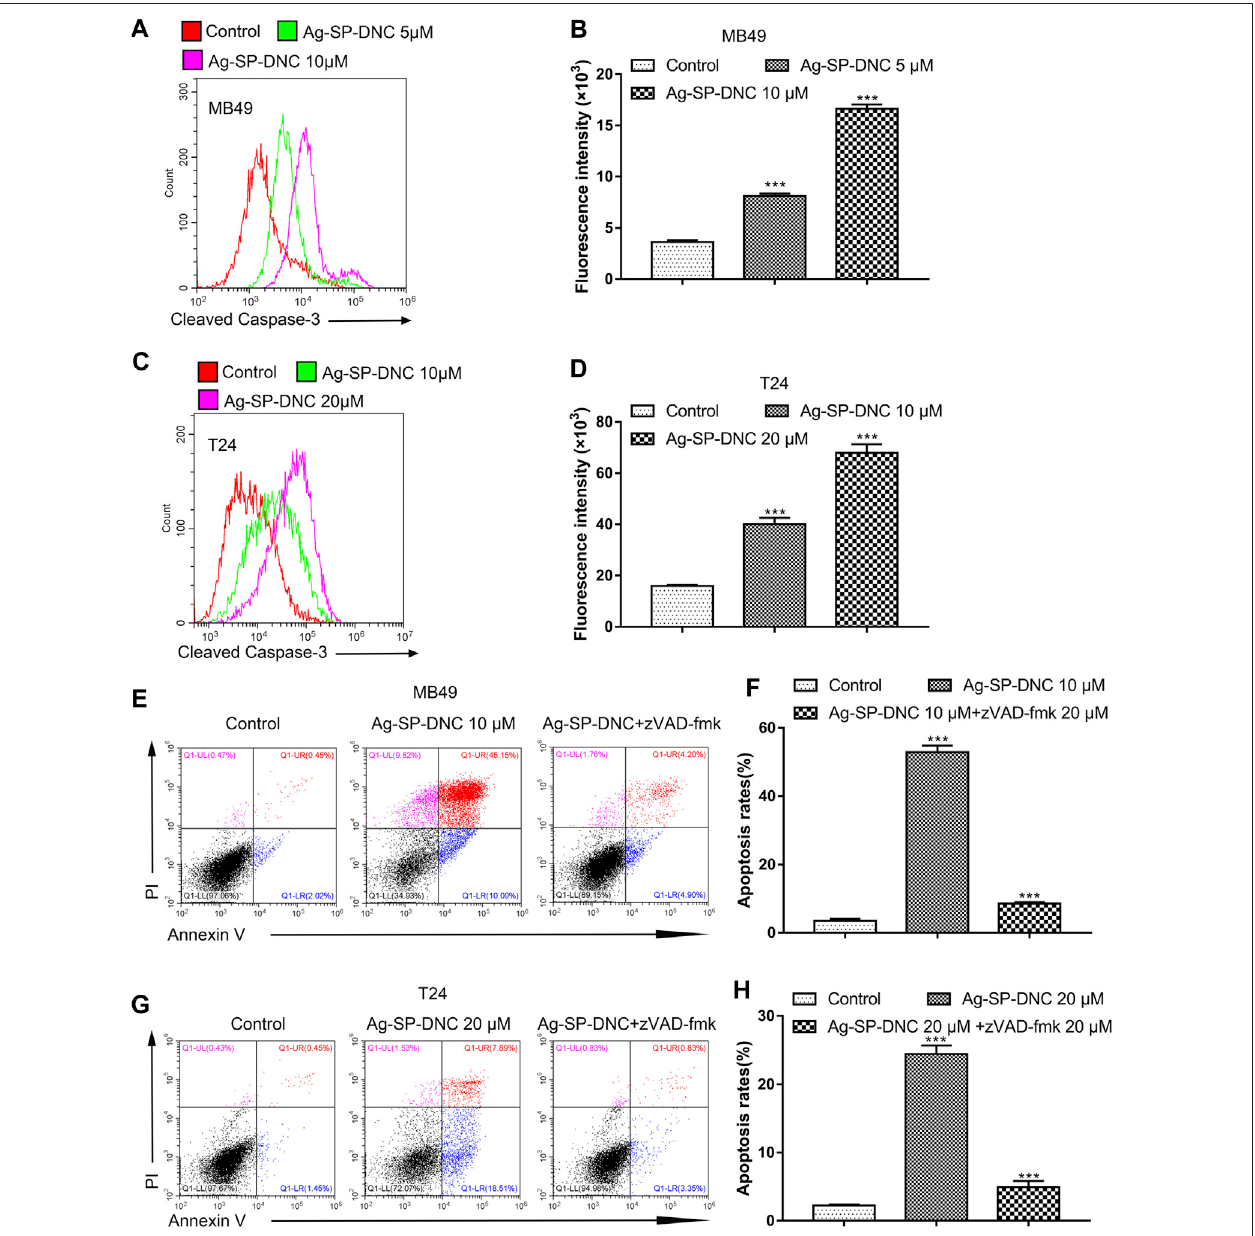
FIGURE 7 | Ag-SP-DNC induces bladder cancer cells apoptosis through cleaved caspase-3. Bladder cancer cells were treated with Ag-SP-DNC for 24 h. The levels of cleaved caspase-3 were measured by fl ow cytometric analyses. (A,B) Cleaved caspase-3 levels of MB49 cells were measured by fl ow cytometry. (A) Representative histograms were shown. (B) Cell associated mean relative fl uorescence intensities. Data are expressed as the mean ± SEM; n (cid:1) 3. *** p < 0.001. (C , D) Cleaved Caspase-3 levels of T24 cells were measured by fl ow cytometry. (C) Representative histograms were shown. (D) Cell associated mean relative fl uorescence intensities. Data are expressed as the mean ± SEM; n (cid:1) 3. *** p < 0.001. (E – H) The bladder cancer cells were treated with Ag-SP-DNC and caspases inhibitorzVAD-fmk for48 h, thenharvestedand stainedwithAnnexin V-FITC and PIfollowed by fl owcytometry analysis. (E) The fl uorescencepatternofAnnexin V-FITC andPIstainedMB49cells. (F) PercentagesofAnnexinVpositivecellsfordifferenttreatments.Dataaremean ± SEM;n (cid:1) 3.*** p < 0.001. (G) The fl uorescencepatternof Annexin V-FITC and PI stained T24 cells. (H) Percentages of Annexin V positive cells for different treatments. Data are mean ± SEM; n (cid:1) 3. *** p < 0.001.